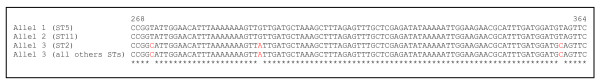
Nucleotide substitutions among the three fumC alleles of C. trachomatis. Sequences between position 268 and 364 with the three nucleotide substitutions are shown. Allele 1 (ST5) has a nucleotide substitution at position 137 (not shown).